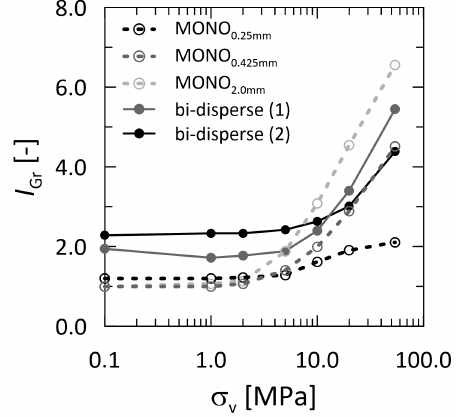
Figure 4. Evolution of the grain size distribution polydisper- sity, by the index of grading, with vertical stress along the one- dimensional compression.